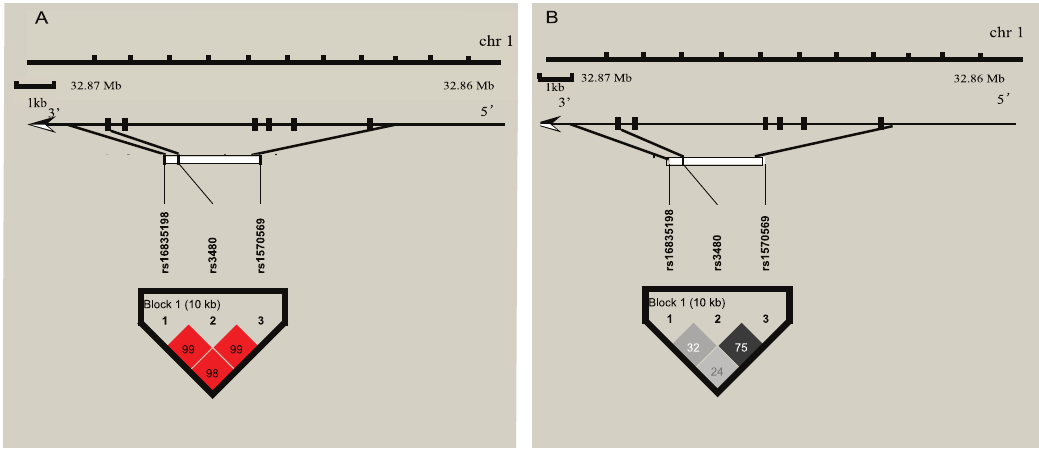
Figure 1. Linkage disequilibrium maps for SNPs genotyped in the region of the FNDC5 gene. A. Shades of red demonstrate the strength of the pairwise linkage disequilibrium based on D’ and numbers represent the value of D’ expressed as a percentage. B. Shades of grey show the strength of the pairwise linkage disequilibrium based on r 2 and numbers indicate the value of r 2 expressed as a percentage. doi:10.1371/journal.pone.0109957.g001 PLOS ONE |